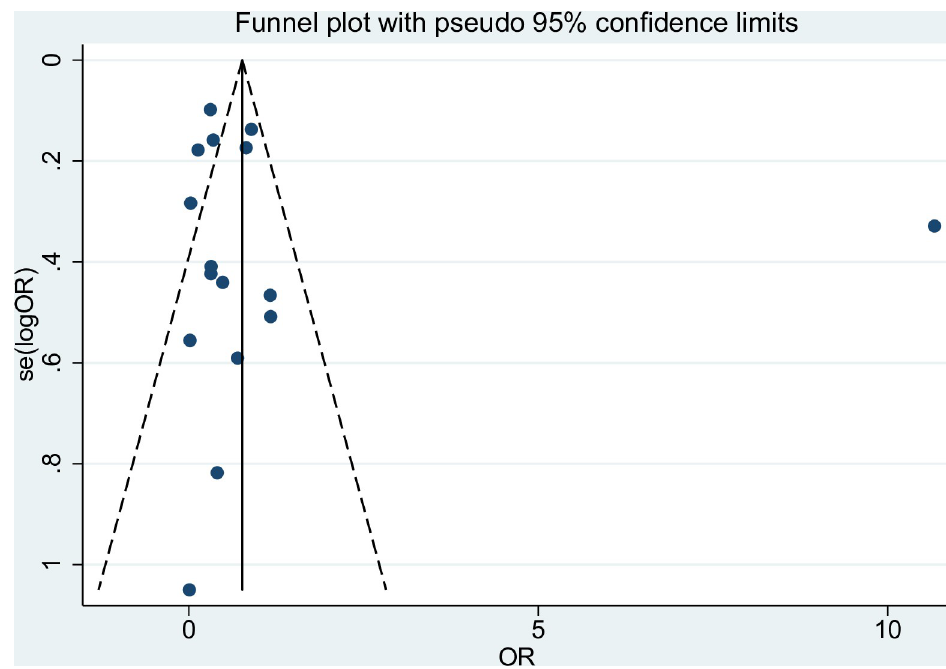
Fig 8. The funnel plot demonstrated the asymmetrical distribution of the effect estimate from the middle line (pooled OR). Abbreviations : OR- odds ratio.